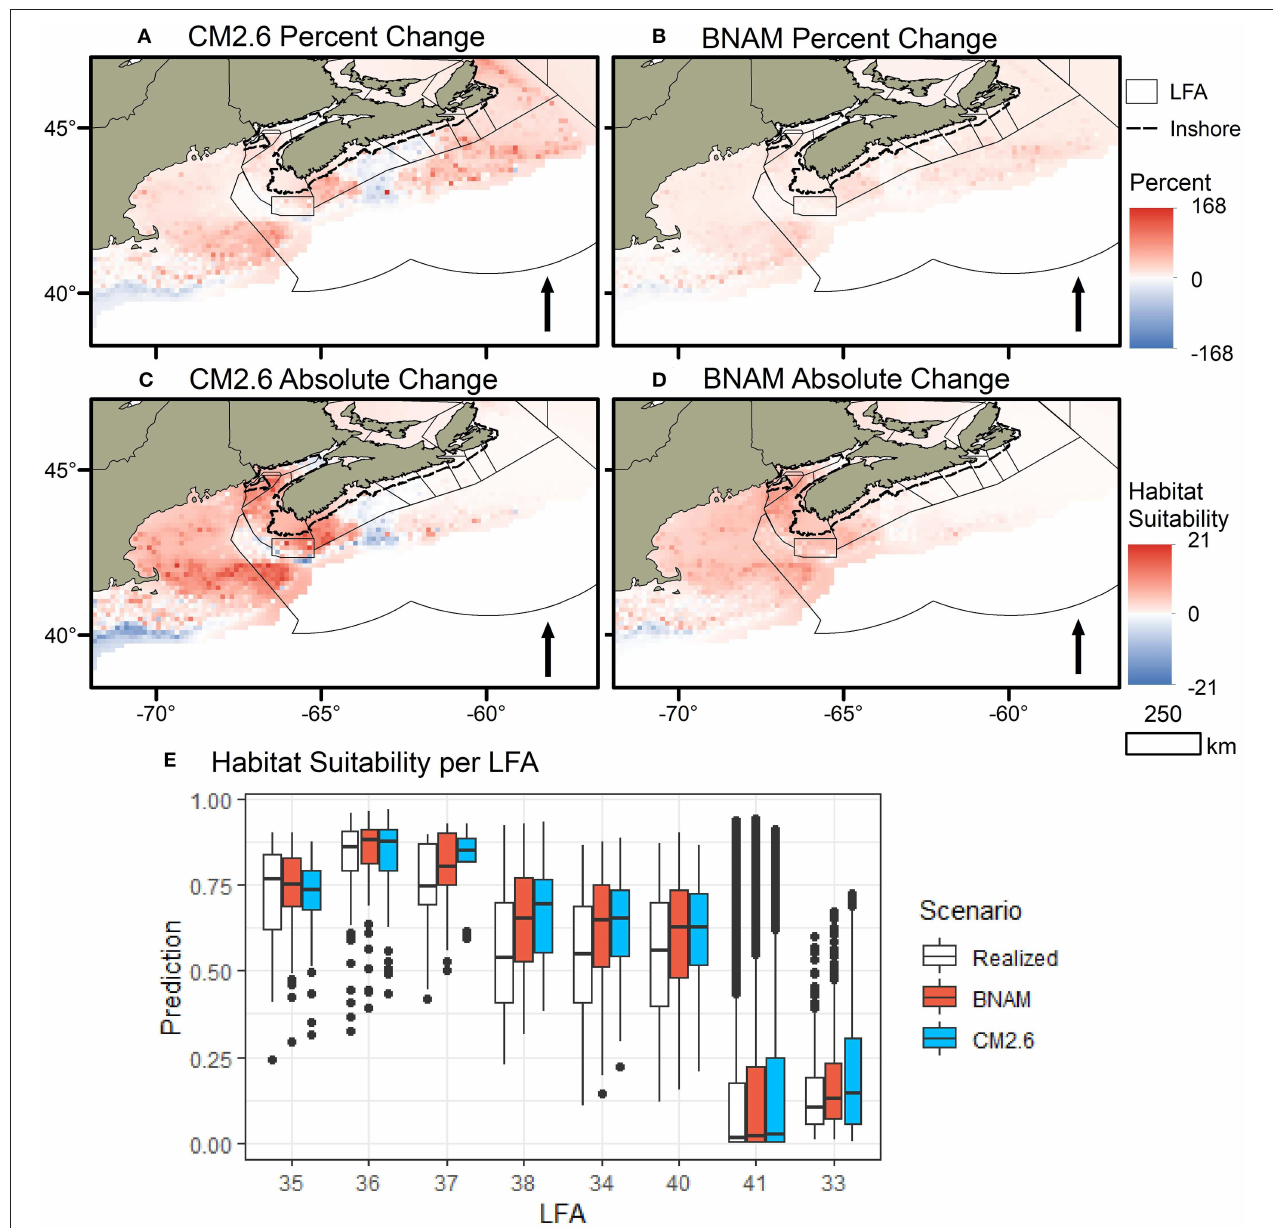
FIGURE 4 | Spatial changes in habitat suitability for American lobster (Homarus americanus ) given projected ocean temperature changes from two scenarios. Habitat suitability is measures on a 0–1 scale, where 0 = low likelihood of the species being present and 1 = a high likelihood of species presence. (A) Percent change in habitat suitability between current and CM2.6 temperature change projections. (B) Percent change in habitat suitability between current and BNAM temperature change projections. (C) Absolute change in habitat suitability between current and CM2.6 temperature change projections. (D) Absolute change in habitat suitability between current and BNAM temperature change projections. (E) Change in median habitat suitability per LFA. Bars show the distribution of median habitat suitability per LFA from 100 model iteration. The black dashed line along the coast of Nova Scotia delineates the extent of the inshore fishery where no data are